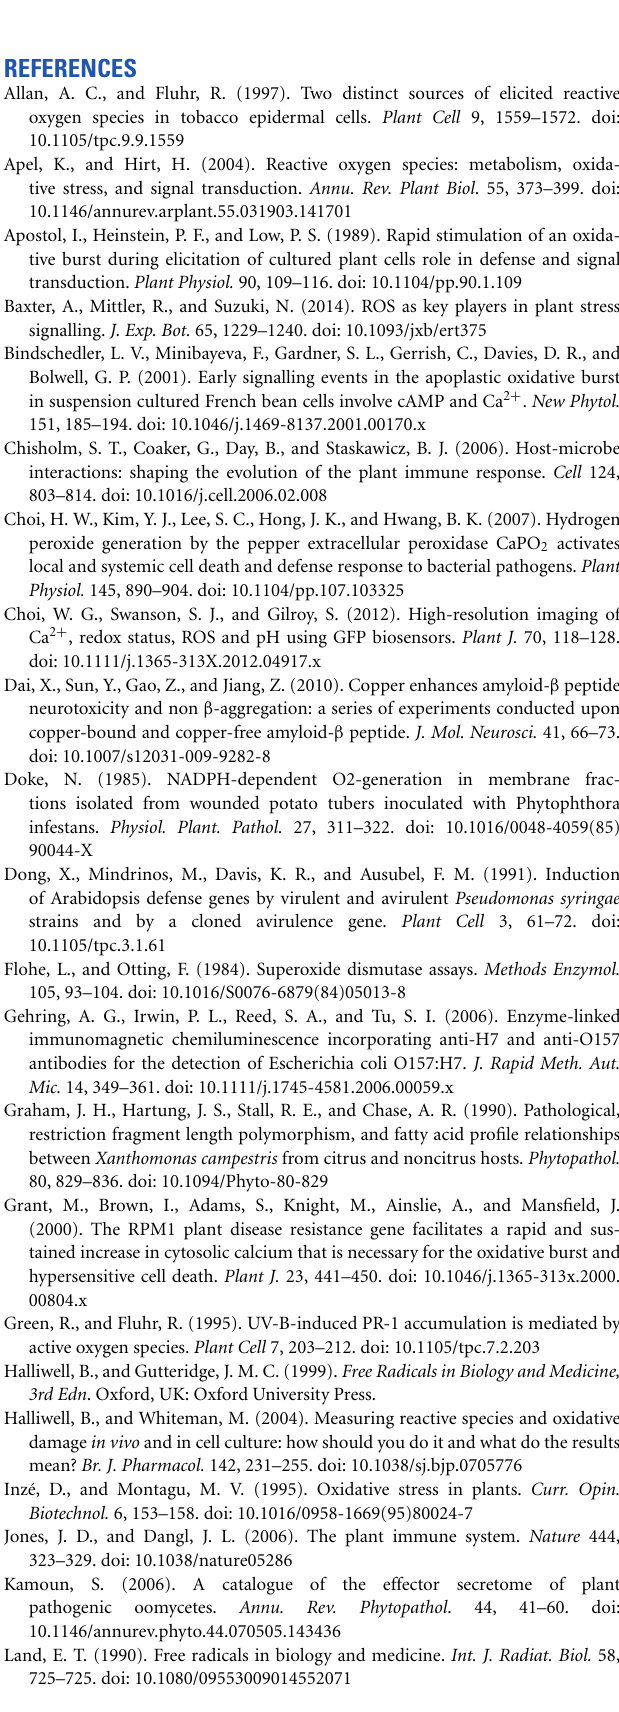
Supplementary Figure 1 | Structure and spectral characteristics of H 2 DCFDA. (A) Molecular structure of H 2 DCFDA. (B) The absorption spectrum of 10 μ M H 2 DCFDA in 0.2% DMSO solution shows a maximum absorption peak at 502nm. In all experiments, however, we used 480nm as the excitation light to avoid the effect of the excitation light on the fluorescence emission. (C) Fluorescence emission spectra of 10 μ M H 2 DCFDA in 0.2% DMSO solution with excitation at 480nm. (D) Fluorescence emission spectra of A. thaliana leave after incubation with 10 μ M H 2 DCFDA in 0.2% DMSO solution. The samples were excited at 480nm, and the spectra show a 6nm redshift when compared with (C) . All spectra were obtained using an LS55 spectrophotometer in the presence of 10 μ M H 2 O 2 applied exogenously to oxidize the H 2 DCFDA. Supplementary Figure 2 | Standard concentration curve of H 2 O 2